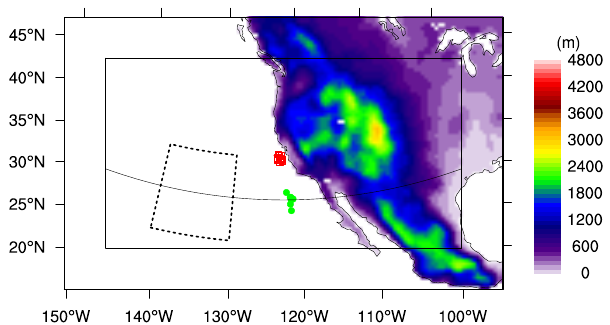
Fig. 1. The topographic height (m) of the western North America (WNA) domain. The solid black box shows the furthest boundary of the buffer zone. The dashed black box shows the area used for averaging in Sect. 7.2, the solid line shows the trace of the transects shown in Sect. 7, and the small red squares and green circles show the locations of field experiments (POST and DYCOMS II, respec- tively) presented in Sect. 6. All figures on this domain are presented with the buffer zone